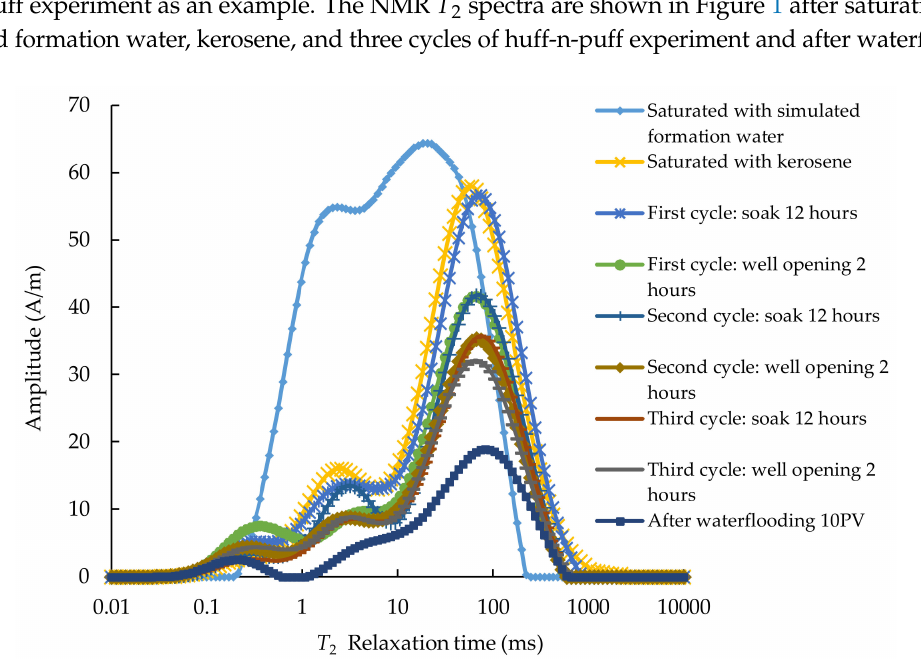
Figure 1. Nuclear magnetic resonance (NMR) T 2 spectra of a tight oil sandstone